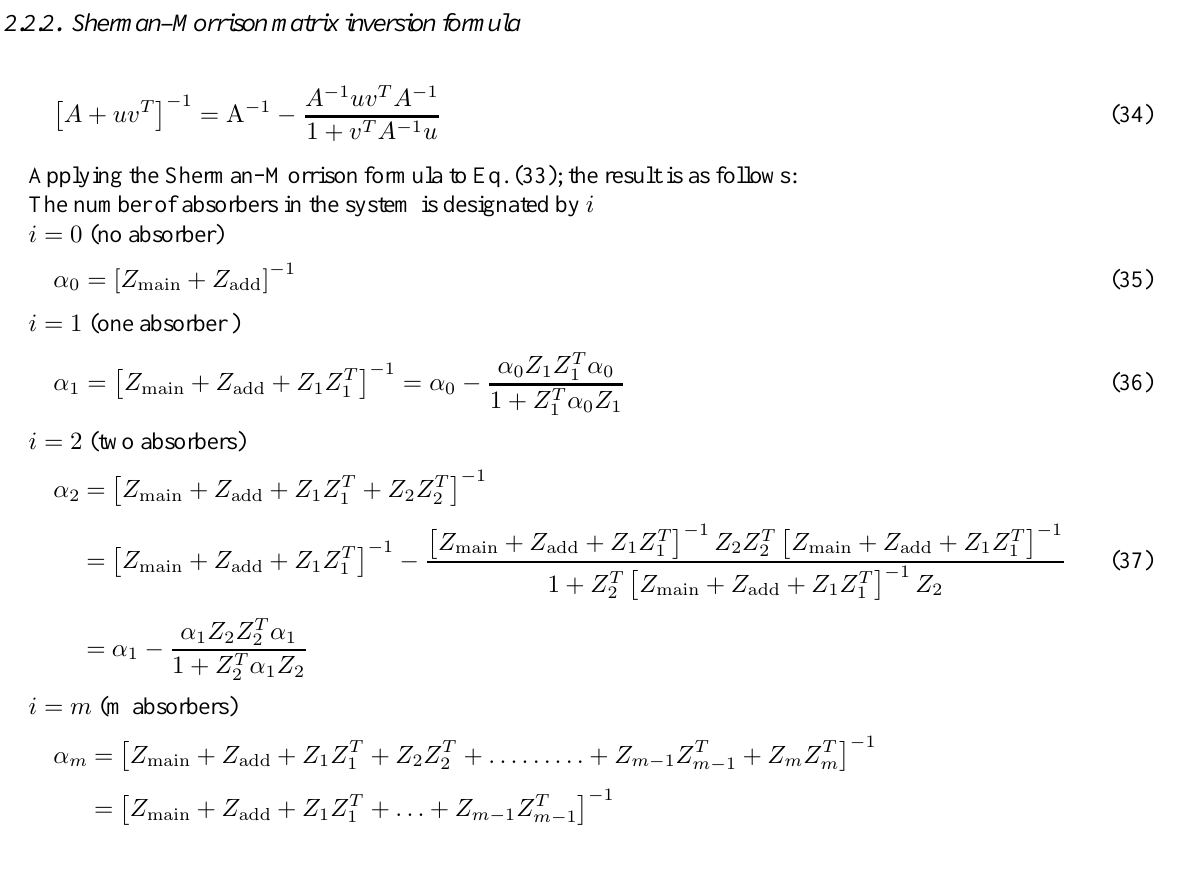
Fig. 11. Displacement of main mass 1, goal function is (0.8x 1 + 0.2x 2 )